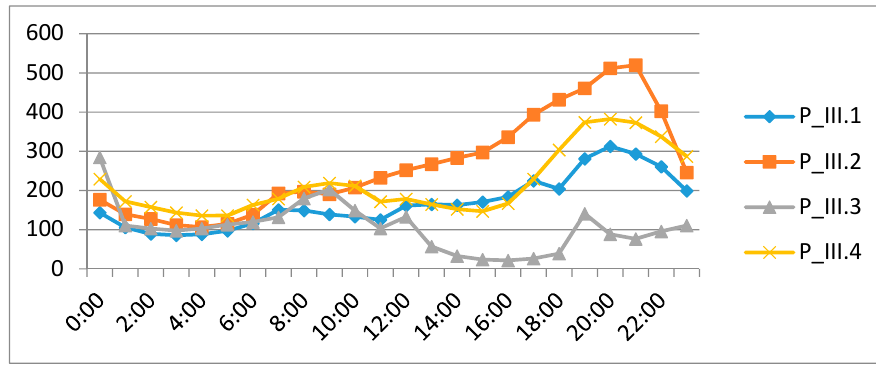
Figure 14. Load profiles obtained with 2 × 3 architecture.